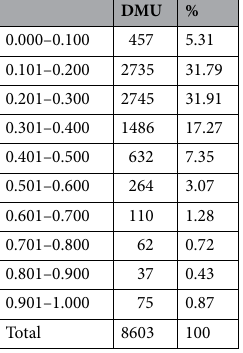
Table 1. Distribution of technical